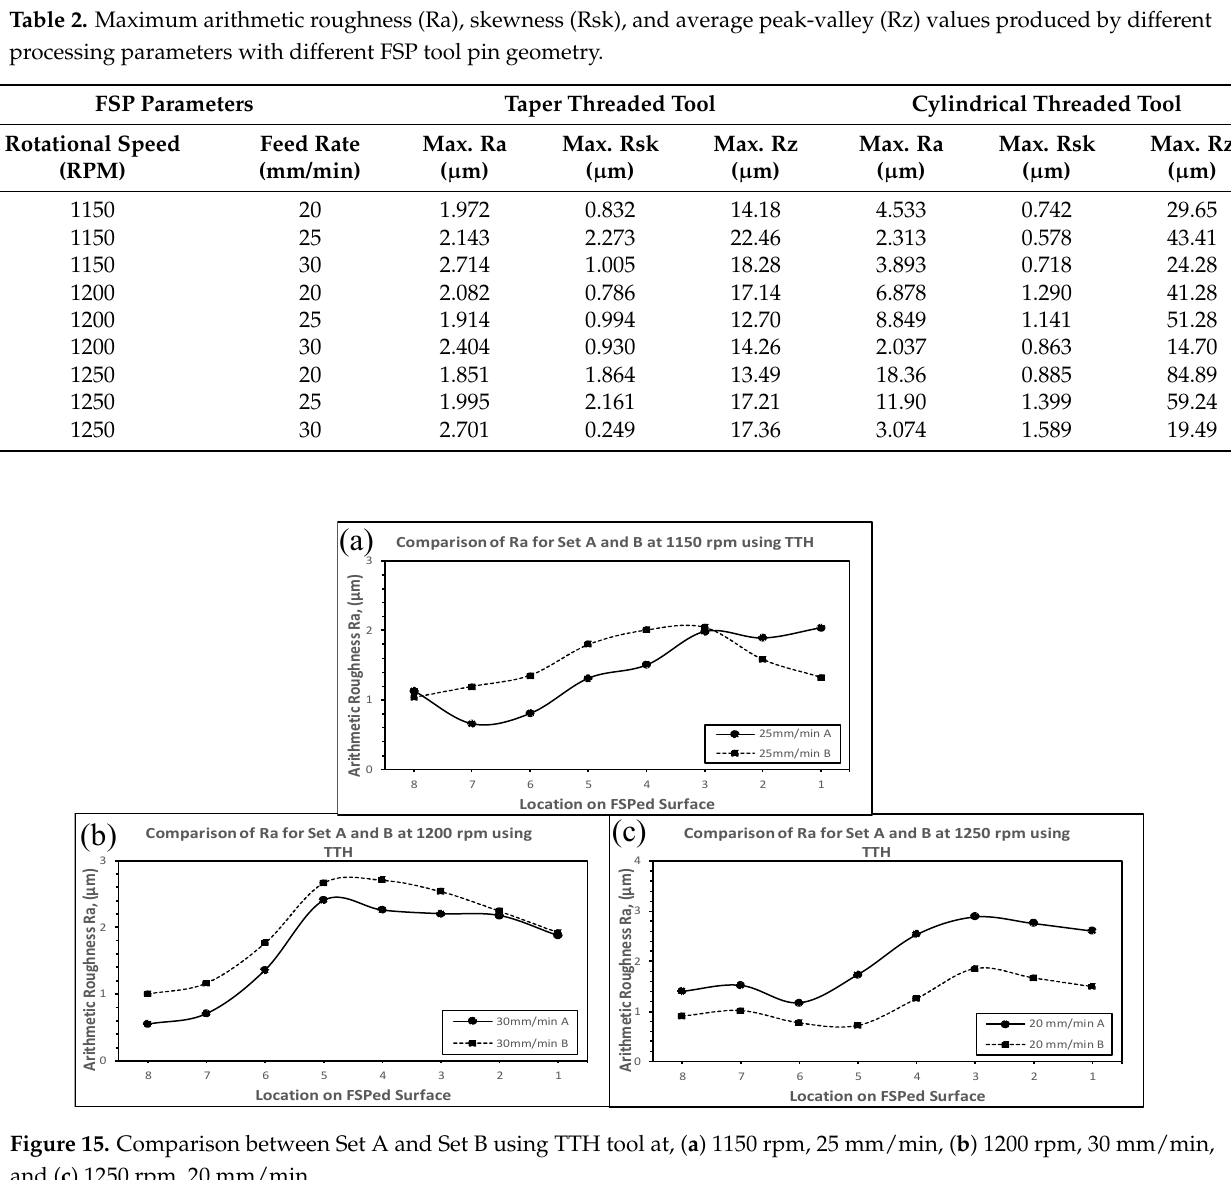
(c) Figure 16. Comparison between Set A and B using CTH tool at, ( a ) 1150 rpm, 30 mm/min, ( b ) 1200 rpm, 20 mm/min, and ( c ) 1250 rpm, 25 mm/min. 3.3. Microstructure Analysis There are two distinct regions observed on the FSPed test samples, namely the stir zone (SZ) and the heat-affected zone (HAZ) [16]. All microstructure images of the FSPed surfaces are captured at 50× magnifications except Figure 17b,c. Microscopy images of all the tested samples that highlighting the HAZ-SZ boundary and SZ are used for compari- son. The microstructure of the parent material and stir zone are shown in Figure 17. Mean-